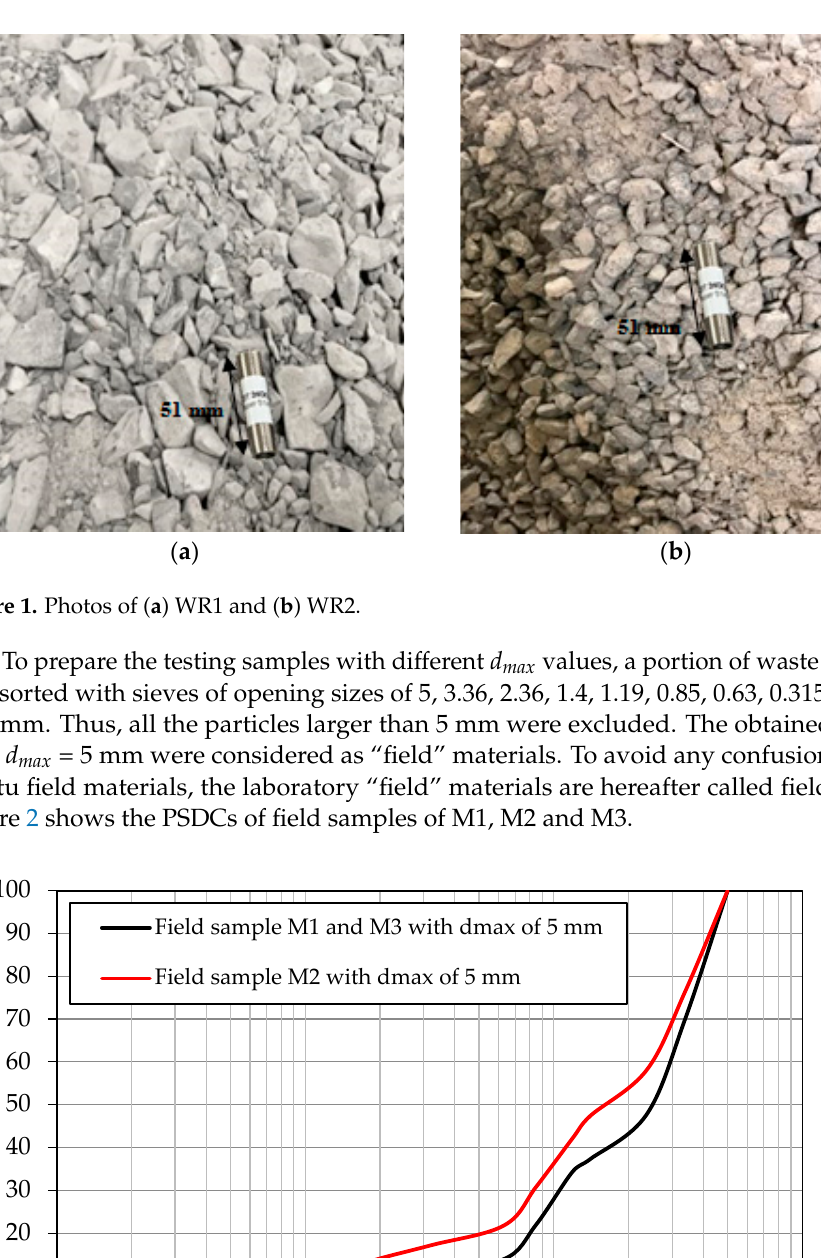
Table 1. Portion distributions of field samples M1, M2 and M3.